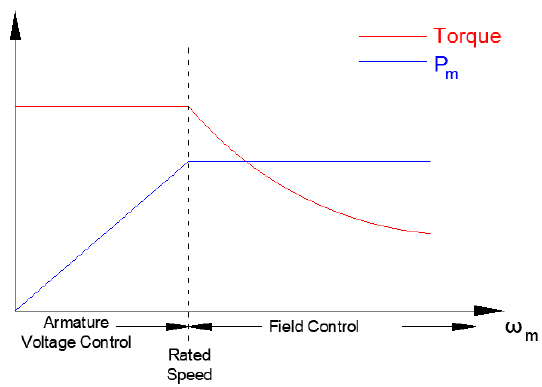
Figure 2. Combined armature and field control of DC motor [27].